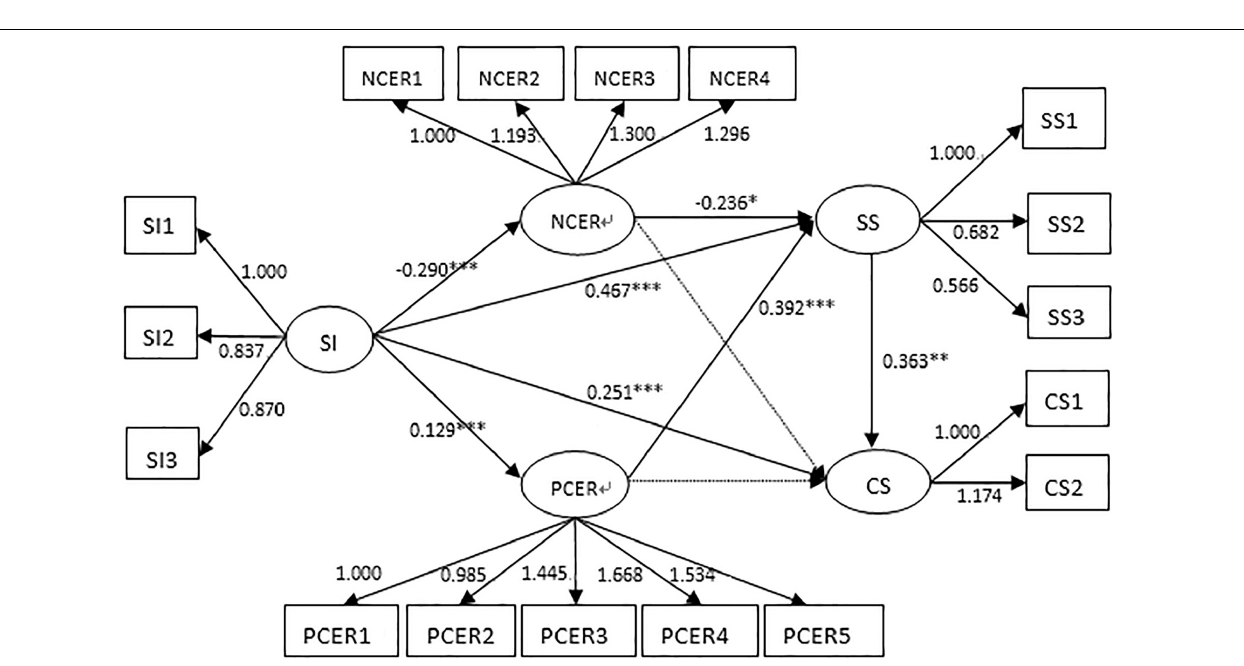
FIGURE 2 | The multiple mediator model of self-identity and career success. SI, self-identity; SI1–SI3, manifest variables of self-identity; NCER, negative cognitive emotion regulation; NCER1–NCER4, manifest variables of negative cognitive emotion regulation; PCER, positive cognitive emotion regulation; PCER1–PCER4, manifest variables of positive cognitive emotion regulation; SS, Social support; SS1–SS3, manifest variables of negative cognitive emotion regulation social support; CS, career success; CS1–CS2, manifest variables of career success; ∗ p < 0.05, ∗∗ p < 0.01, and ∗∗∗ p <